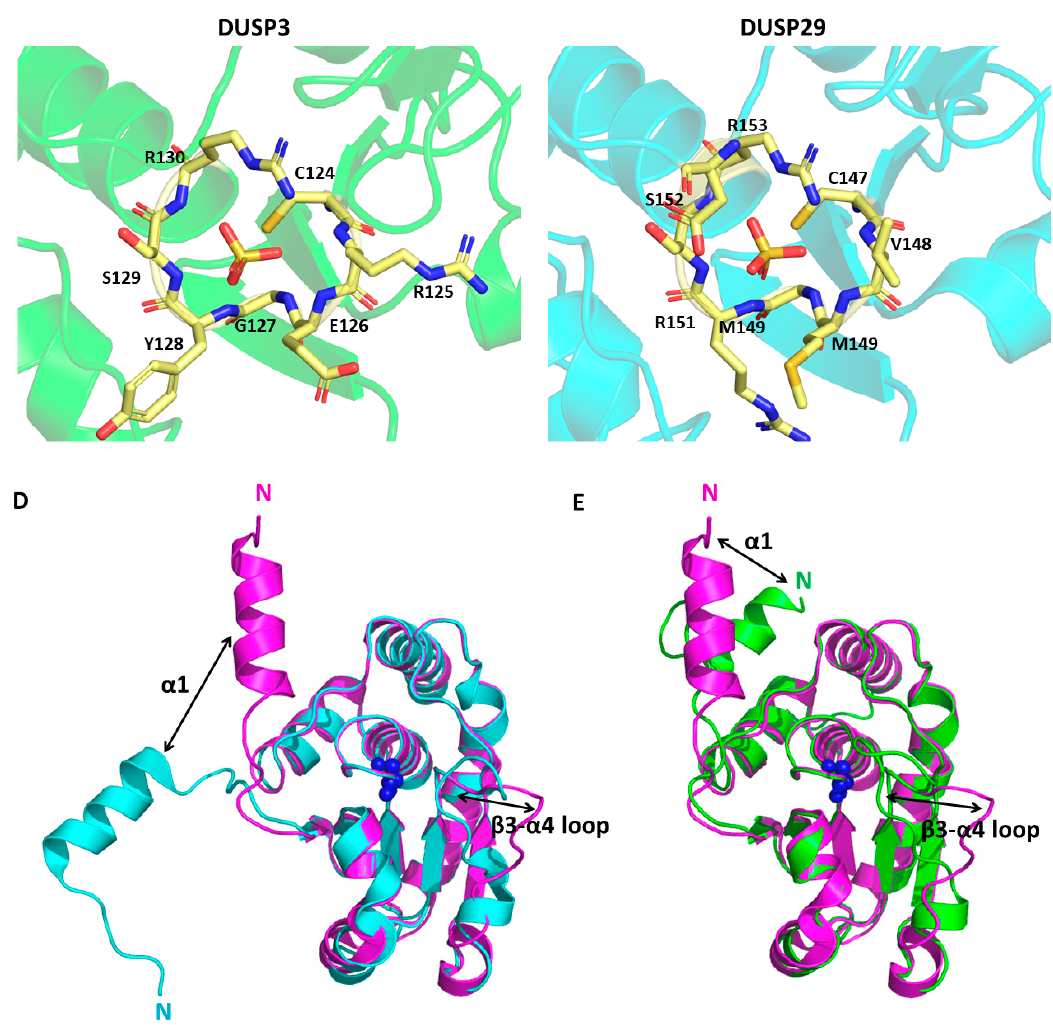
Figure 2. DUSP26 structure and comparison to homologous proteins. Protein Data Bank (PDB) file retrieved from the RCSB PDB Database and loaded into the Pymol software. ( A ) Schematic of protein domain structure depicting N- and C-terminal domains. ( B ) Crystal structure of DUSP26-N monomer presented with the catalytic triad surrounding the phosphate ion. ( C ) PTP-loop residues of DUSP26-N, DUSP26-C, DUSP3 and DUSP29 surrounding a phosphate (DUSP26-N and DUSP26C) or sulphate (DUSP3 and DUSP29) ion. The phosphate ion residing in the DUSP26-C PTP-loop has been superimposed from the DUSP26-N structure. Black arrows identify amide bonds in the DUSP26-C PTP-loop that are not pointing towards the phosphate ion centre. Structural alignment of DUSP26-N (magenta) with ( D ) DUSP3 (cyan) and ( E ) DUSP29 (green). Disparate structural regions are depicted by double-edged arrows and the catalytic Cys152 depicted as blue spheres. PDB codes : DUSP26-N, 5GTJ; DUSP26-C, 2E0T; DUSP3, 1VHR; DUSP29, 2Y96. Figures adapted from [43] .